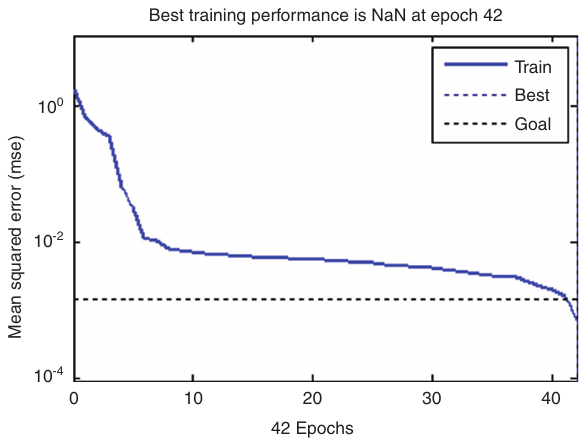
Figure 5 Iteration-dependent error variation graphic of the